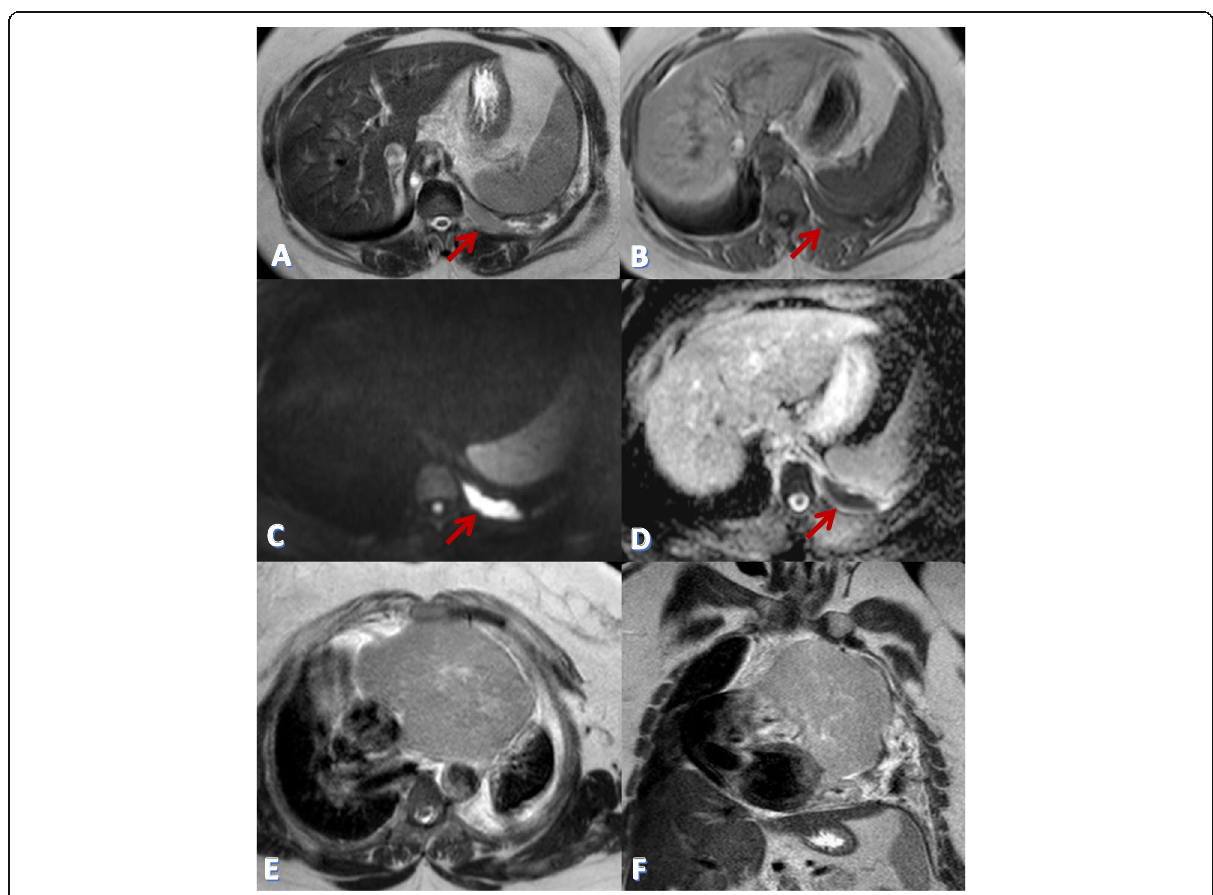
Fig. 5 a Axial T2 WI and b axial T1 WI showing left focal nodular pleural thickening (red arrows) eliciting low T1 and high T2 signal intensities with left moderate pleural effusion eliciting heterogeneous low T1 and high T2 signal. c DWI and d ADC map showing restricted diffusion of the pleural thickening with the bright areas on the DWI corresponding to dark areas on the ADC map (red arrows), while the pleural effusion was non-restricted (pleural thickening and effusion showed ADC mean = 0.54 × 10 − 3 mm 2 /s and 3.07 × 10 − 3 mm 2 /s respectively). e Axial T2 and f coronal T2 WI, showed anterior mediastinal lesion. CT-guided biopsy revealed pleural metastasis from invasive thymoma and malignant pleural